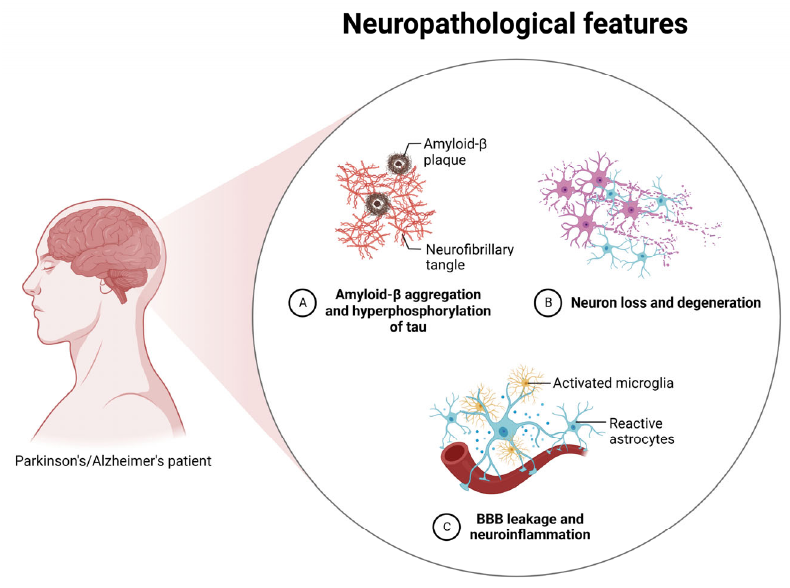
Figure 1. Pathophysiology of Alzheimer’s and Parkinson’s disease. Generally, the formation of amyloid- β plaques and neurofibrillary tangles results in neuron loss and degeneration. This triggers an uncontrolled immune response resulting in BBB leakage and neuroinflammation (created with BioRender.com) (accessed on 3 January 2023).